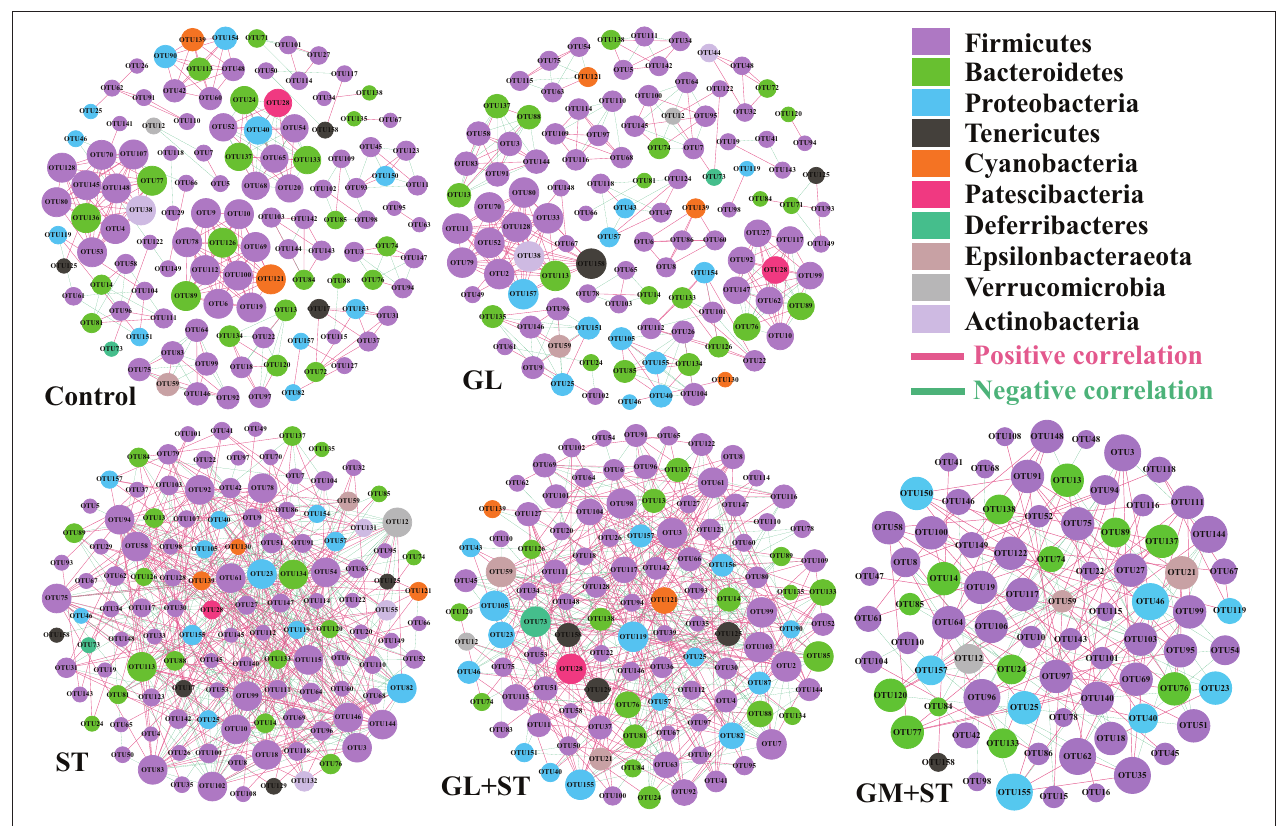
FIGURE 9 | Co-occurrence networks of microbial communities at genus level. A connection stands for a very strong (Spearman’s R > 0.6) and significant (FDR-adjusted P < 0.05) correlation. The size of each node is proportional to the relative abundance; the thickness of each connection between two nodes (edge) is proportional to the value of Spearman’s correlation coefficients. Red lines represent significant positive correlations and green lines denote negative correlations.